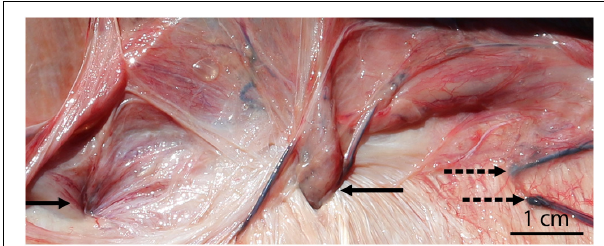
FIGURE 8 | Acute abdominal hernias in a bycaught bottlenose dolphin (with the peritoneum reflected back). Blood vessels are visible at the site of both hernias (solid arrows), and congestion/hemorrhage is present surrounding the hernia on the left. Additional emissary veins (not associated with hernias) are also present (dashed arrows) and may predispose the region to